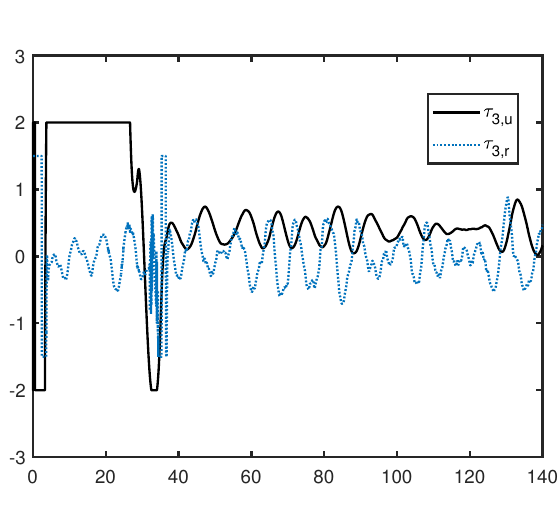
Figure 11. Control input of USV 3.